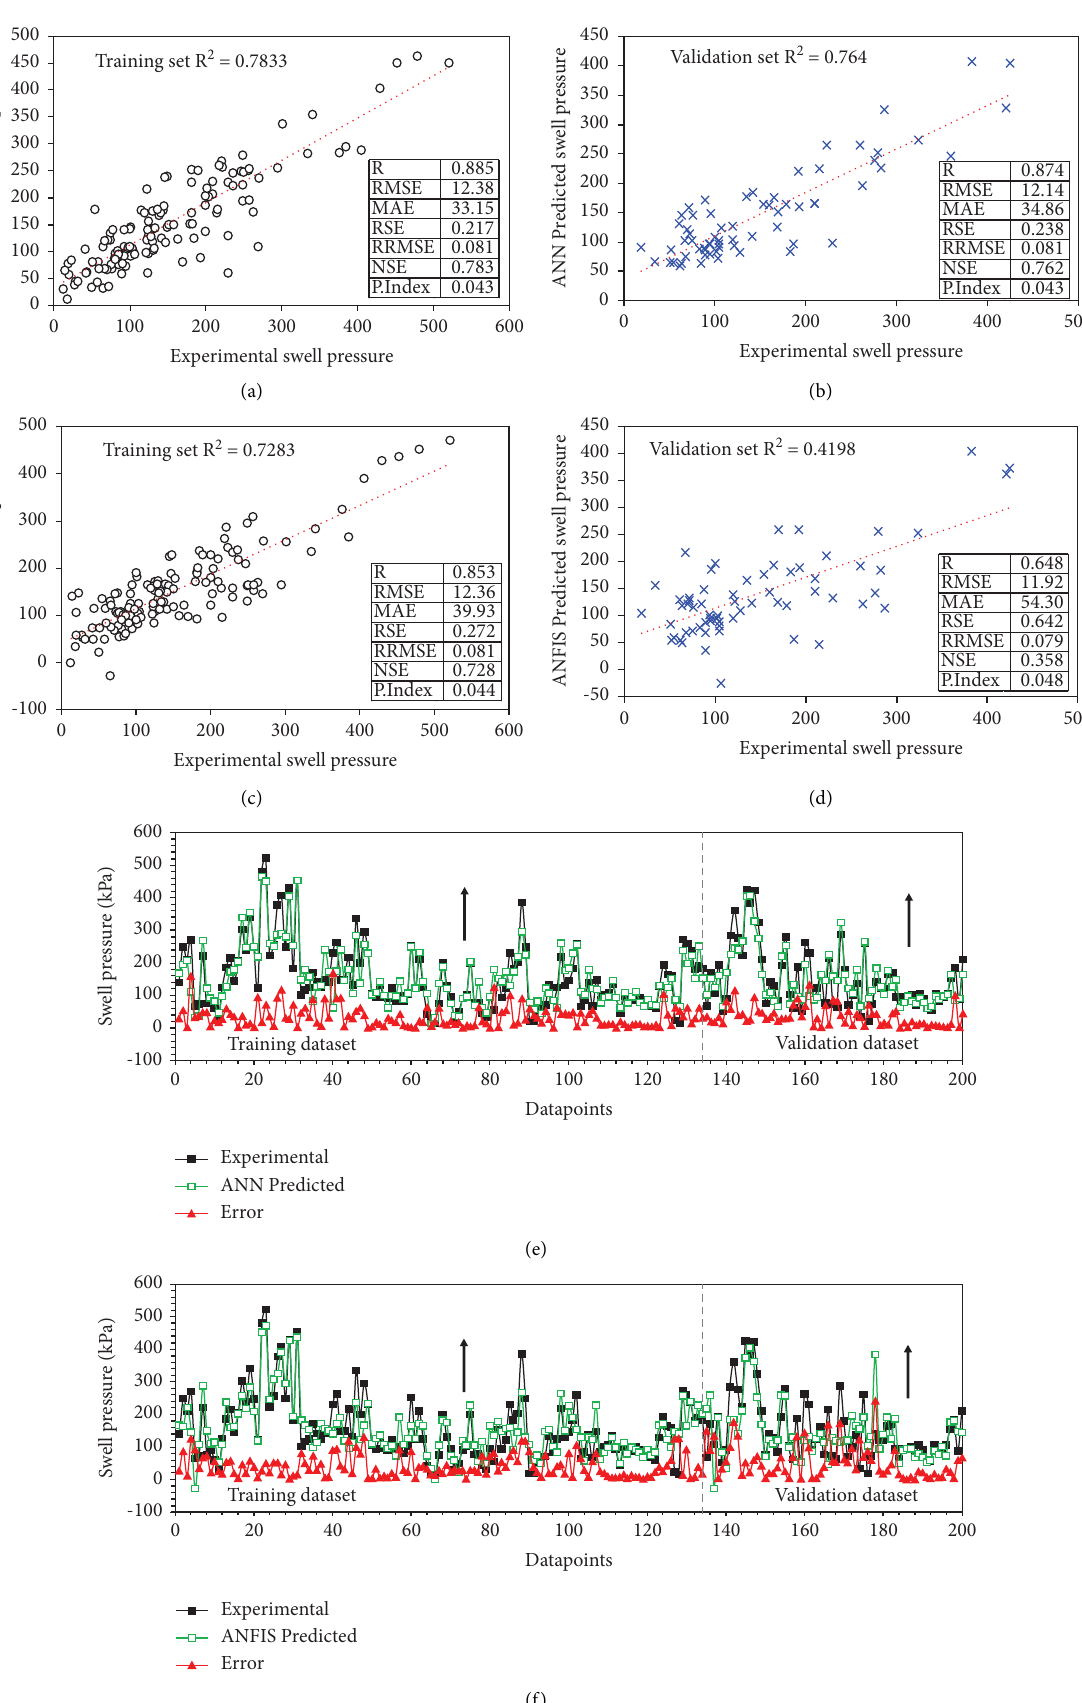
Figure 8: Experimental versus predicted swelling pressure using neural network-based approaches with performance